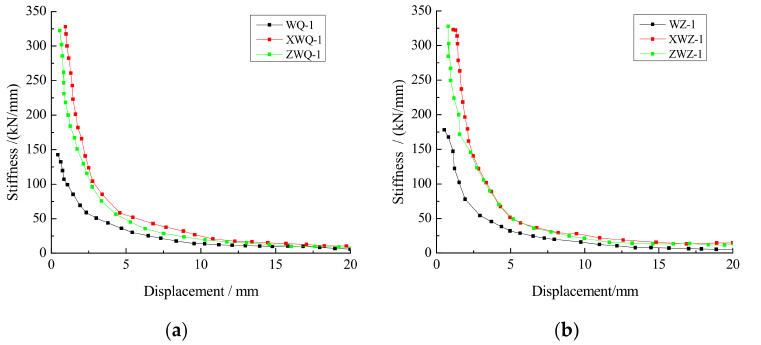
Figure 17. Stiffness–displacement curves: ( a ) common brick masonry walls; ( b ) autoclaved fly-ash- brick masonry